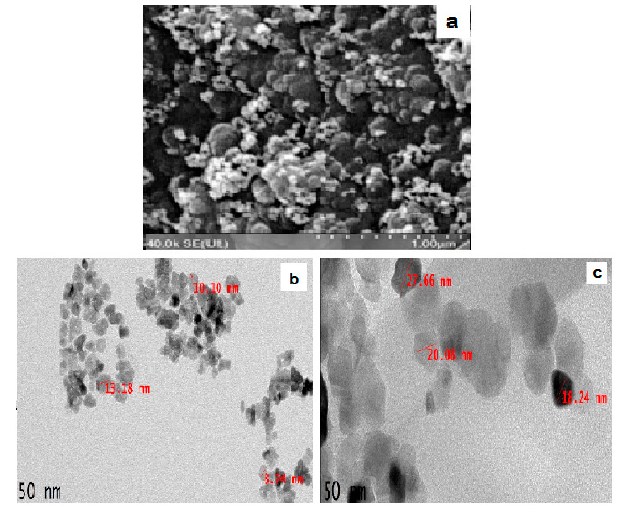
Figure 1. The XPS spectra of Ppy-CS-TiO 2 nanocomposite films: ( a ) survey scan; ( b ) C 1s, ( c ) O 1s, ( d ) N 1s, and ( e ) Ti 2p narrow scans.